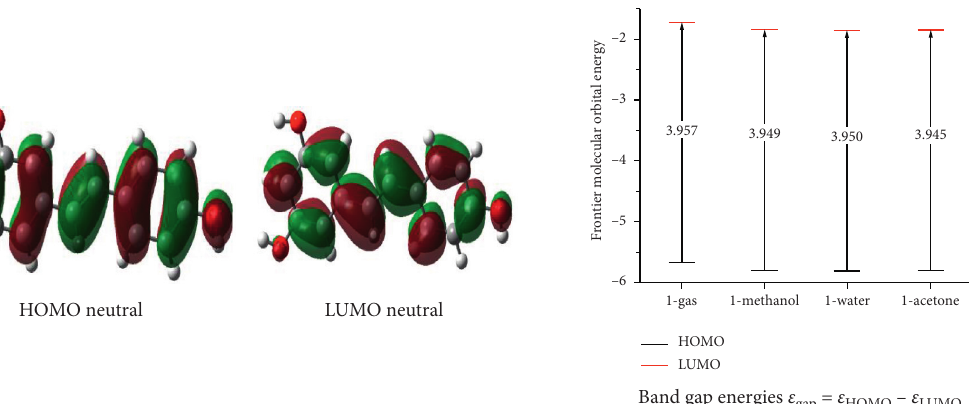
Figure 3: HOMO and LUMO images of structural neutral and radicals and band gap energies ε